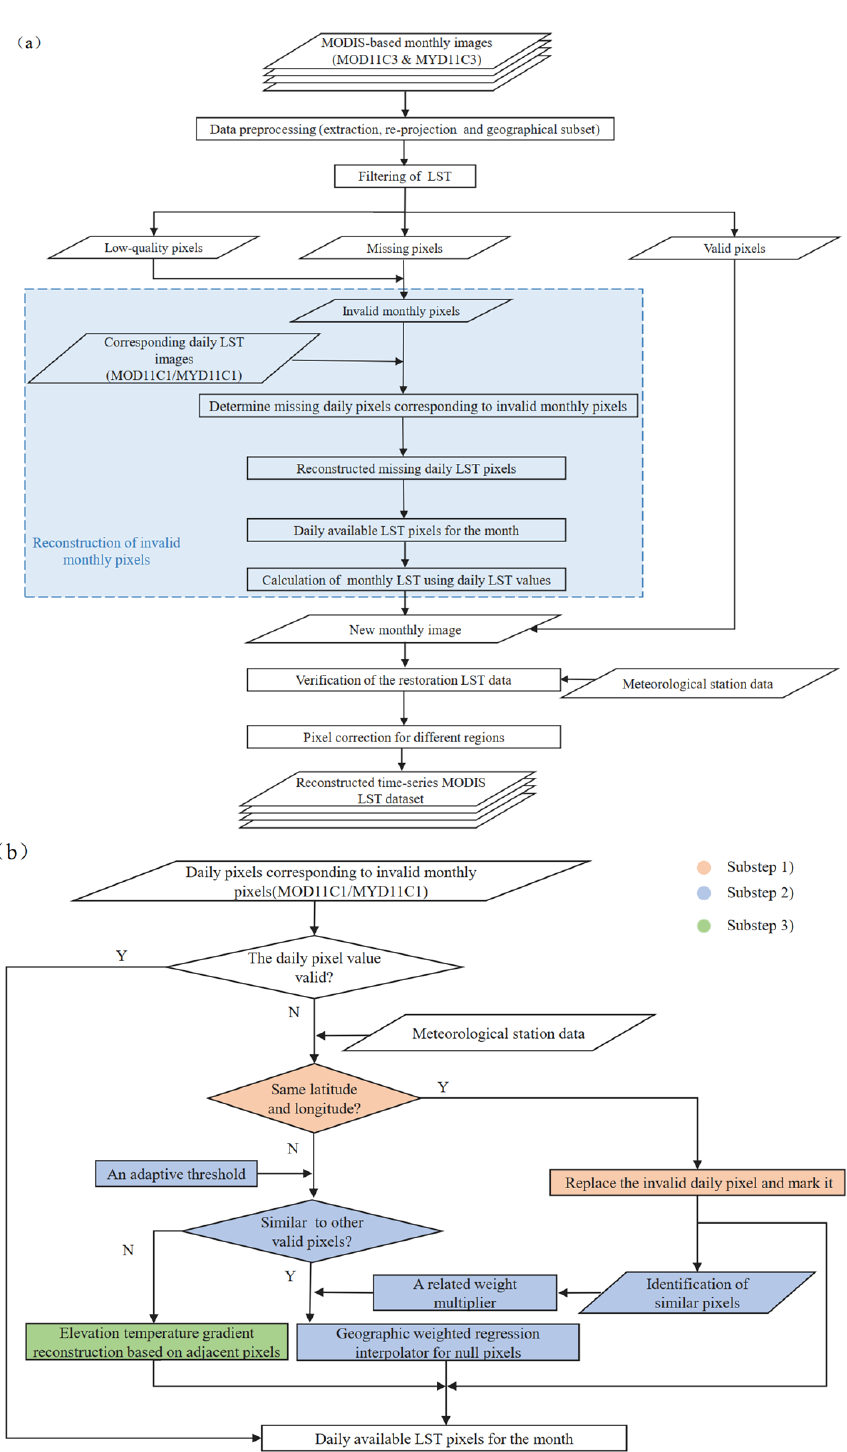
Figure 2. (a) The summary flowchart for reconstructing MODIS monthly LST data; (b) the detailed flowchart for reconstructing missing daily pixels in (a)